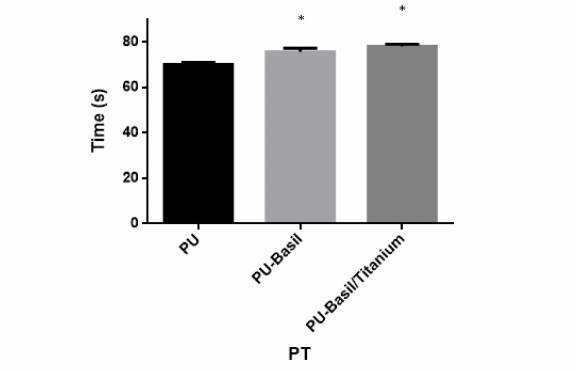
Figure 11. Activated partial thromboplastin time (APTT) assay of PU, PU / BASIL and PU / BASIL / TiO 2 .